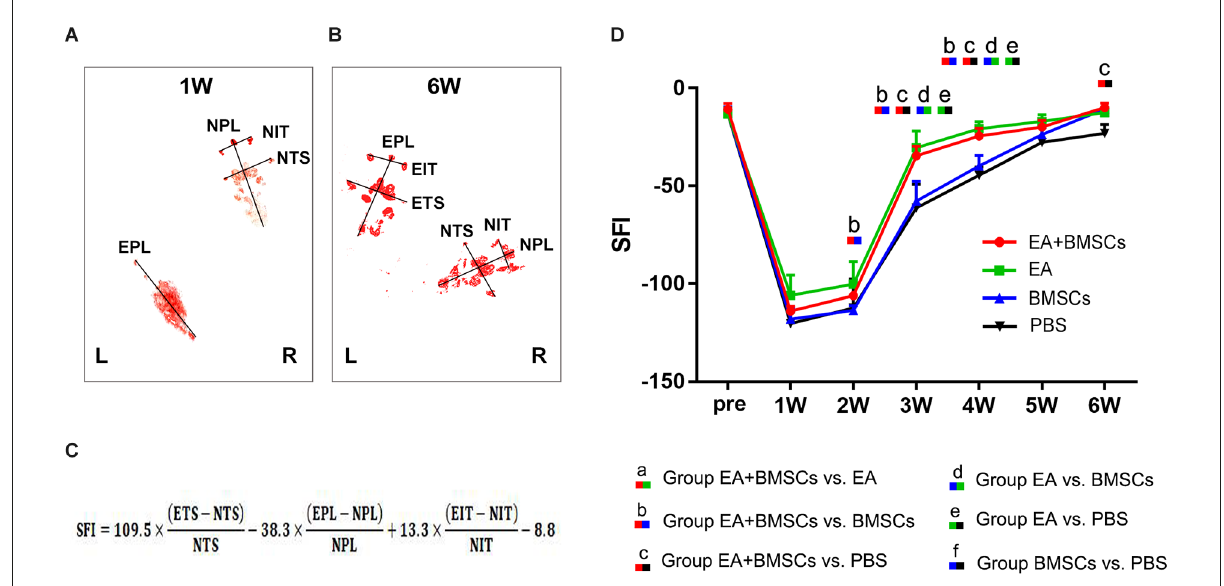
FIGURE8 Walking track analysis of the sciatic nerve-injured rats. (A,B) Hind paw footprints of the EA + BMSCs subgroup at 1 and 6 weeks post-surgery. (C) The formula to calculate the sciatic functional index (SFI) is shown as derived by multiple linear regression (EPL, experimental print length; NPL, normal print length; ETS, experimental toe spread; NTS, normal toe spread; EIT, experimental intermediary toe spread; and NIT, normal intermediary toe spread). (D) Sciatic nerve function index (SFI) of the injured side compared with the uninjured contralateral side post-surgery in the four sub-groups. The SFI of acquisition points within groups were compared by using one-way ANOVA with Bonferroni post-hoc testing, and statistically significant differences are listed in Table 5 .